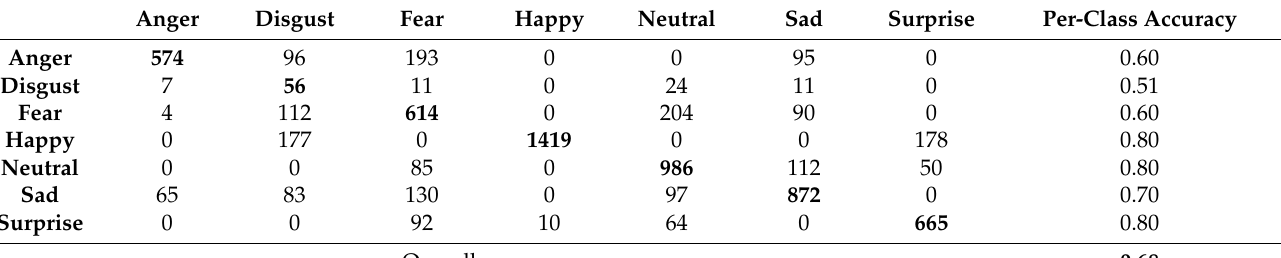
Table 5. Cross-validation over the FER-2013 dataset.